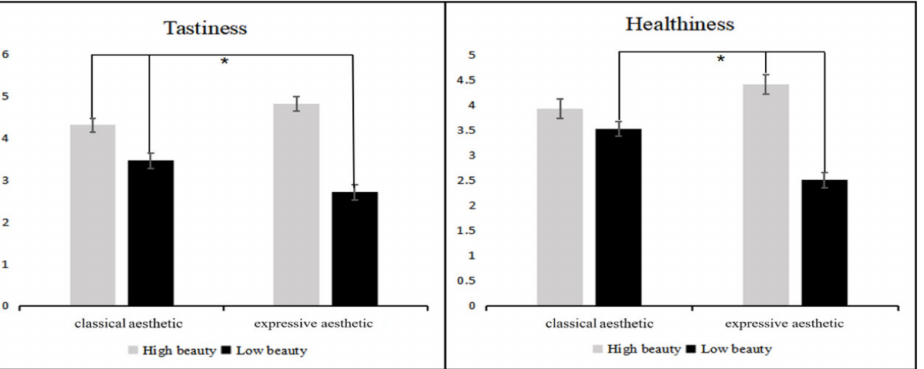
Figure 5. Tastiness scores ( left ) and healthiness ( right ) for plates with different pattern types and different beauty levels. Error lines represent 95% confidence intervals. Significant differences (*) are indicated between the connecting lines.